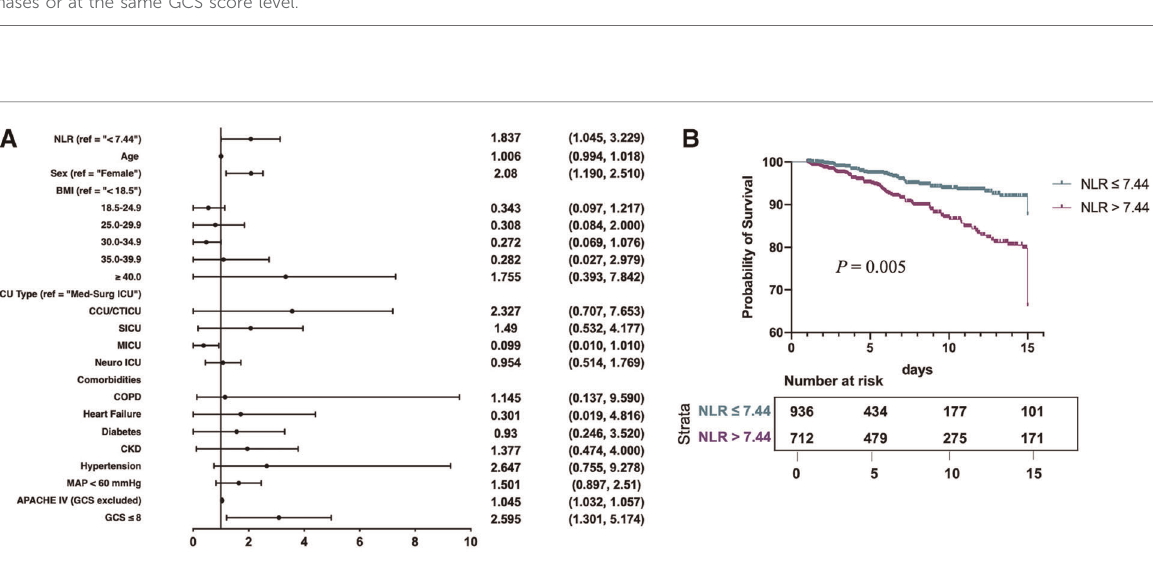
FIGURE 4 Multivariate regression model and adjusted survival curves in traumatic brain injury patients: ( A ) multivariate logistic regression model was used to show that the higher NLR was an independent risk factor of ICU mortality for traumatic brain injury patients, and ( B ) the adjusted cumulative survival curve indicated the marked survival disadvantage in NLR>7.44 compared with NLR ≤ 7.44 ( P